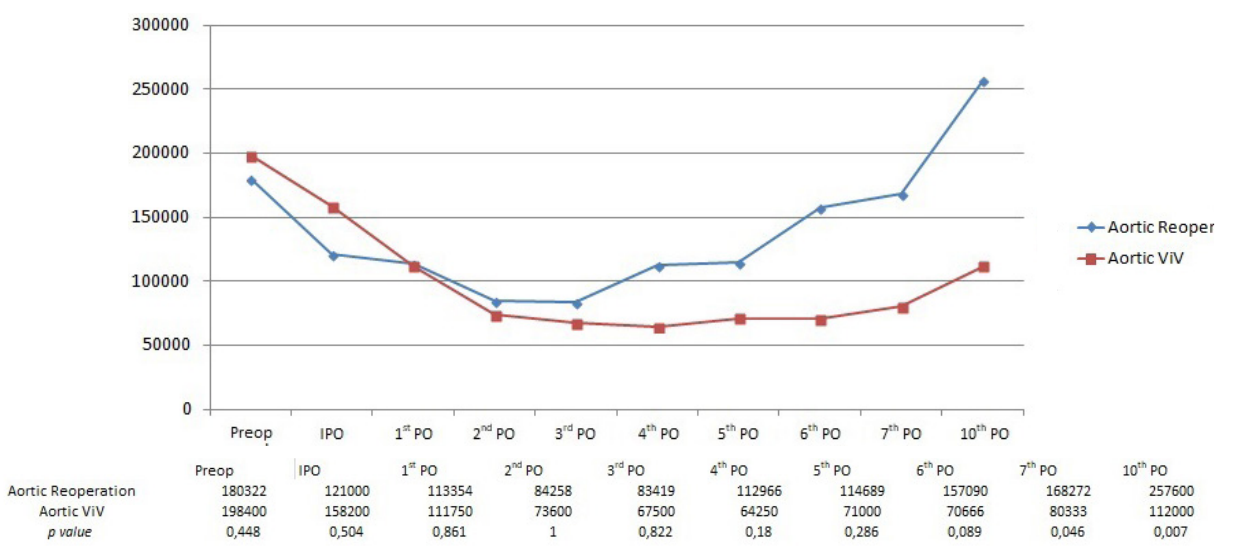
Fig. 3 - Comparison between mean platelet values for conventional aortic reoperation and aortic valve-in-valve (VIV)